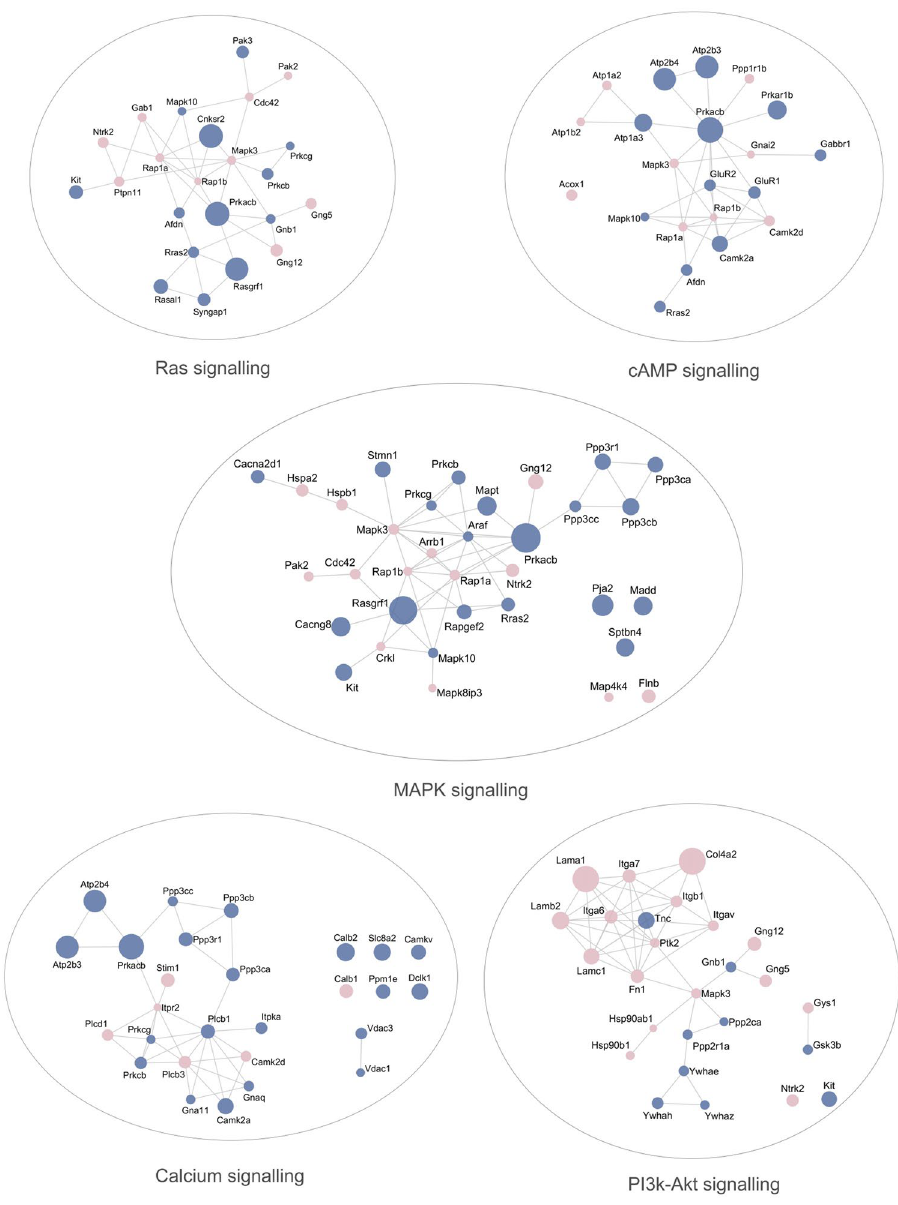
in female (pale pink) and male (blue) hippocampus, and node size indicates different levels of fold change relative to each individual network. STRING online database were used to obtain protein–protein